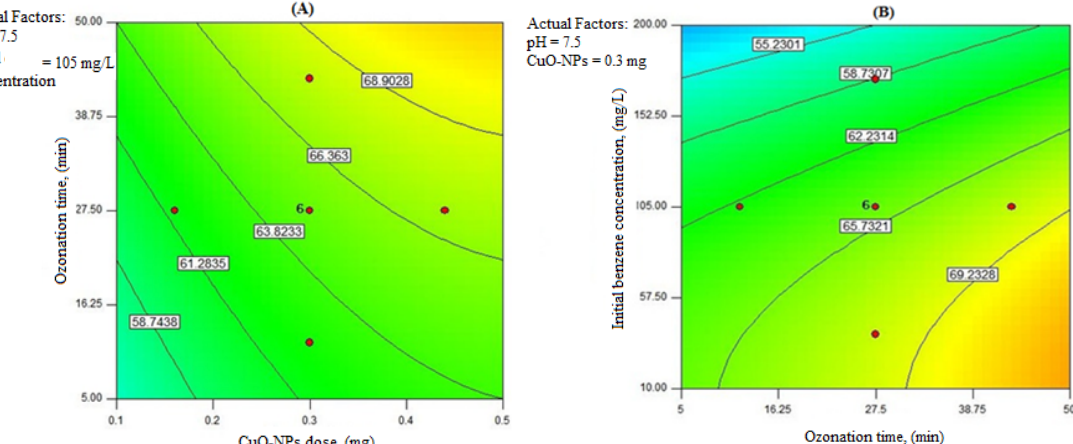
Fig. 5: (A) Interaction effects of ozonation time/contact time and CuO-NPs dose; and (B) effects of ozonation time/contact time and initial concentration of benzene